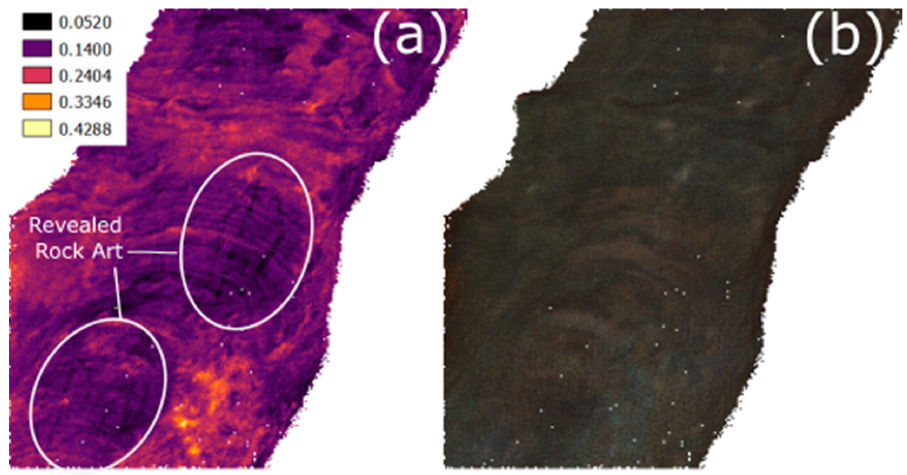
Figure 5. A multicolor visualization ( a ) of the TLS intensity values for Figure 3c. Three potential rock art are revealed in the TLS data that are not seen in an RGB image the same area ( b ).